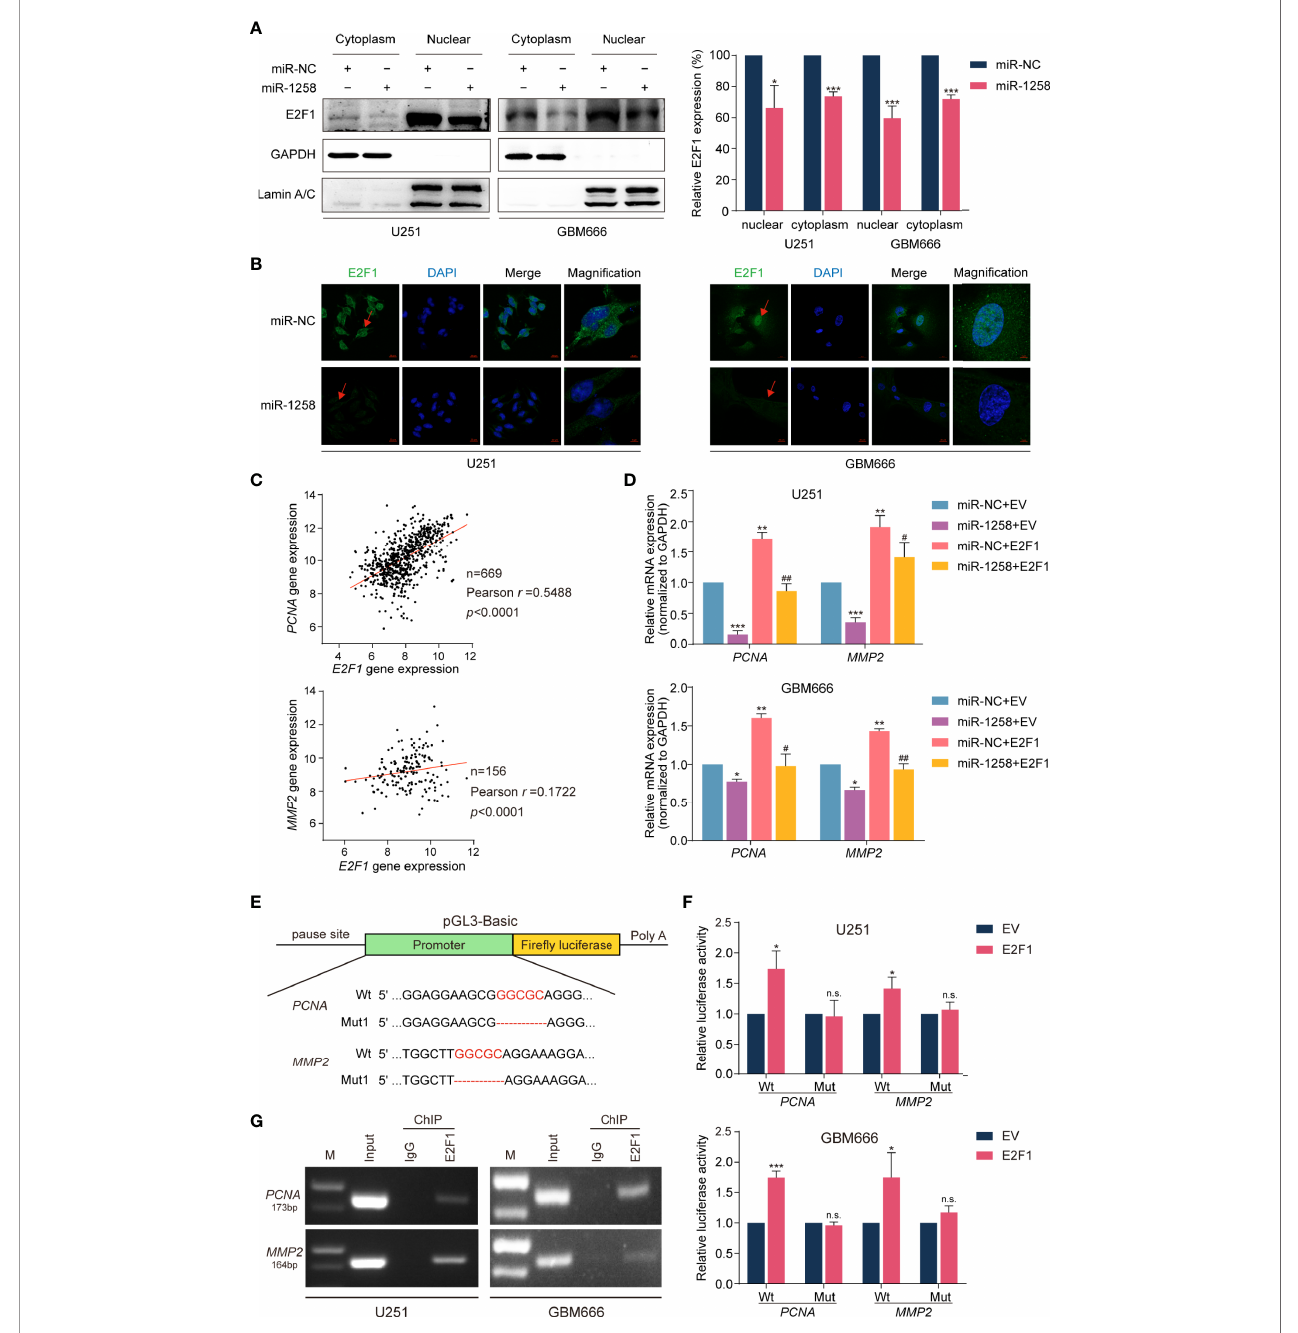
FIGURE 5 | miR-1258 exerts inhibitory effects via transcriptional regulation of PCNA and MMP2 by E2F1. (A) The decreased expressions of E2F1 in U251 and GBM66 cells transfected with miR-1258 in cytoplasmic and nuclear fraction were detected by western blot; *p < 0.05, ***p < 0.001 when compared to miR-NC group. (B) Immuno fl uorescence assays were applied to analyze GBM cells transfected with miR-1258 or miR-NC. Cell nuclei were stained by DAPI. Red arrows showed the nuclear expression of E2F1. Scale bar = 20 m m. In magni fi cation, Scale bar = 5 m m. (C) The correlations between E2F1 gene expression and PCNA , MMP2 levels in the TCGA database were analyzed by Pearson ’ s correlation analysis; r = 0.5488, p < 0.0001 in E2F1-PCNA , r = 0.1722, p < 0.0001 in E2F1-MMP2 . (D) The mRNA expressions of PCNA and MMP2 in miR-1258 transfected GBM cells were restored by E2F1 using the qRT-PCR assay; *p < 0.05, **p < 0.01, ***p < 0.001 versus the miR-NC+EV group. # p < 0.05, ## p < 0.01, versus the miR-1258+EV group. (E) The schematic diagram illustrated the construction of PCNA and MMP2 WT and Mut promoter sequences in the pGL3-Basic vector. (F) Dual-Luciferase reporter assays were used to assess GBM cells transfected with luciferase vectors carrying WT or Mut promoter sequences of PCNA and MMP2 upon transfection of an E2F1 expression vector or EV; *p < 0.05, ***p < 0.001, n.s., no signi fi cance between E2F1 and EV group. (G) ChIP assays were used to analyze the enrichment of E2F1 on the PCNA and MMP2 promoter region in GBM